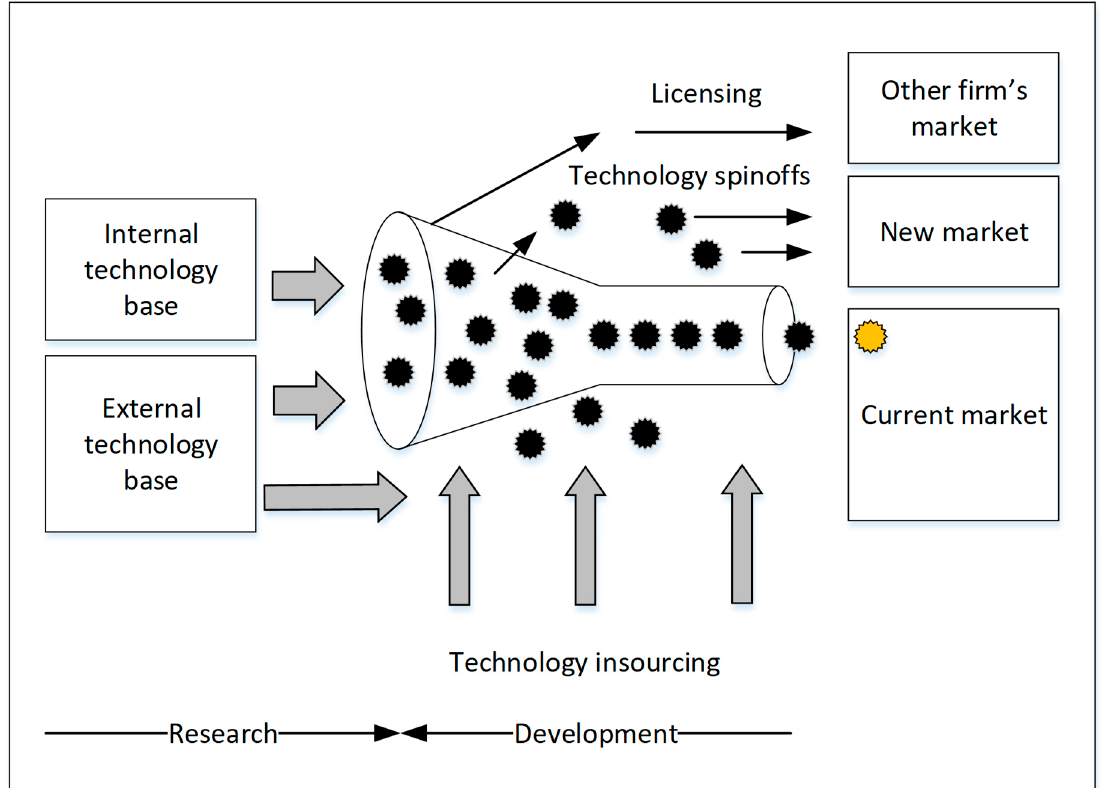
Figure 6. The open innovation paradigm (sources from Reference [90]).